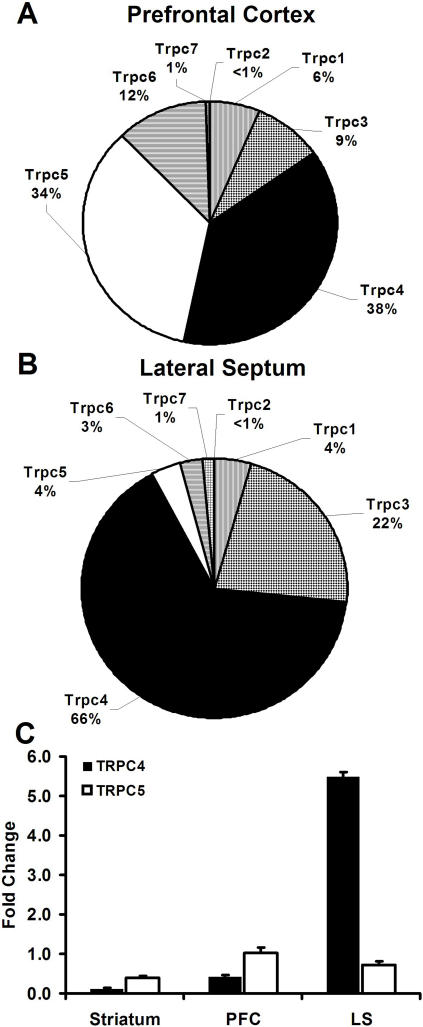
Region-specific expression of TRPC4 and TRPC5 mRNA.(A–B) Pie charts showing the relative expression of the seven TRPC channels in rat prefrontal cortex (A) and lateral septum (B). Results was normalized to GAPDH mRNA levels. (n = 4; PFC TRPC1: Avg = 0.00055, SEM = ±0.000035; TRPC3: Avg = 0.00073, SEM = ±0.000066; TRPC4: Avg = 0.0031, SEM = ±0.00035; TRPC5 Avg = 0.0021, SEM = ±0.0010; TRPC6: Avg = 0.00010, SEM = ±0.000038; TRPC7: 0.000049, SEM = ±0.0000021; LS TRPC1: Avg = 0.0011, SEM = ±0.000020; TRPC3: Avg = 0.000082, SEM = ±0.000042; TRPC4: Avg = 0.0051, SEM = ±0.000011; TRPC5: Avg = 0.0015, SEM = ±0.00015; TRPC6: Avg = 0.00016, SEM = ±0.0000063; TRPC7: Avg = 0.00015, SEM = ±0.0000014) (C) Quantification of TRPC4 and TRPC5 mRNA levels in the striatum, prefrontal cortex (PFC), and lateral septum of adult rat using real-time PCR. Results was normalized to GAPDH mRNA levels. (n = 4)